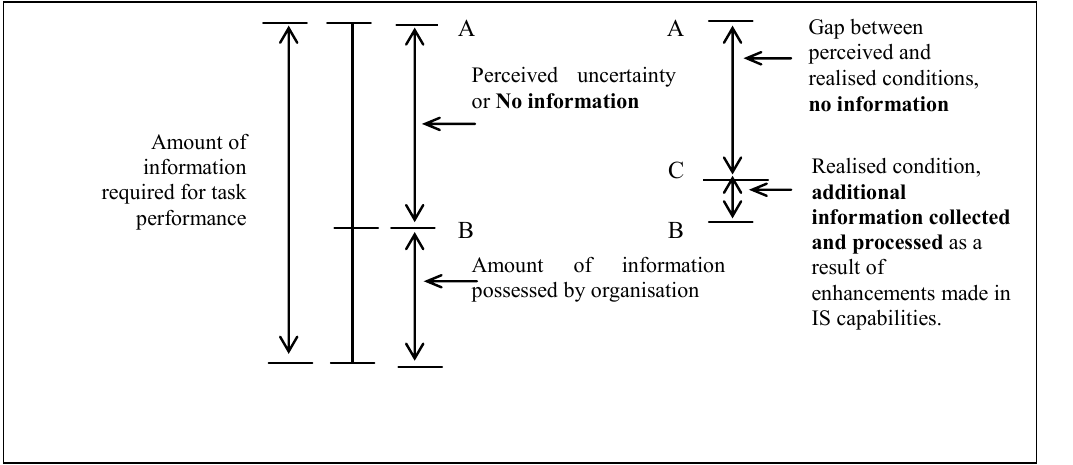
Figure 4: Gap between perceived and realised conditions